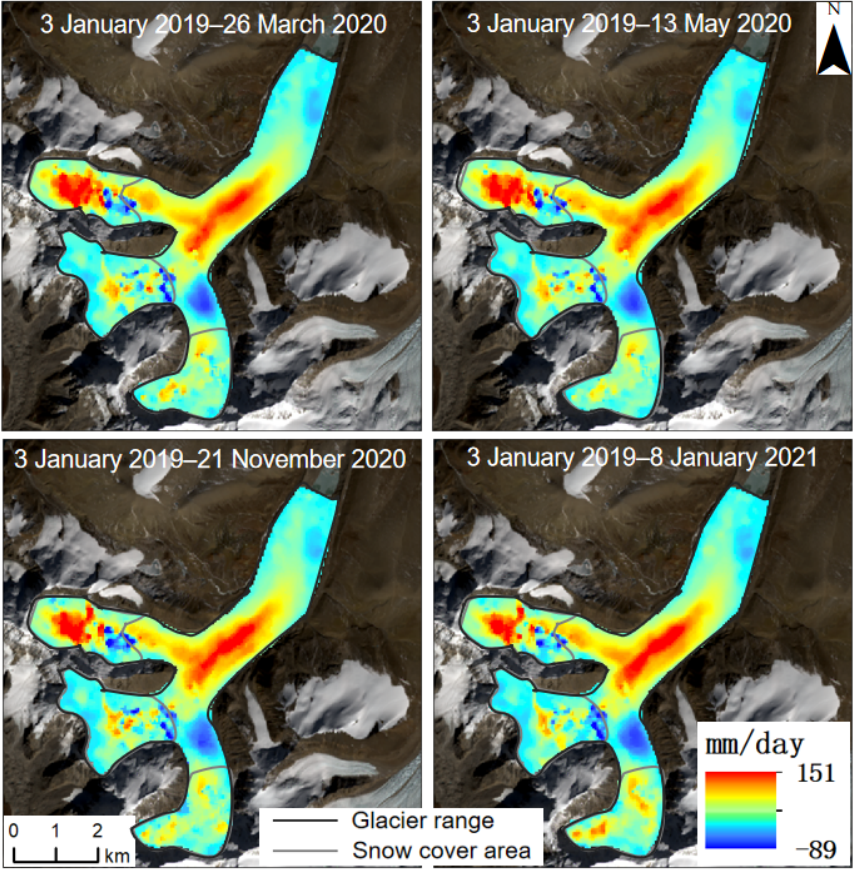
Figure 14. Vertical time-series glacier velocity in the study area.